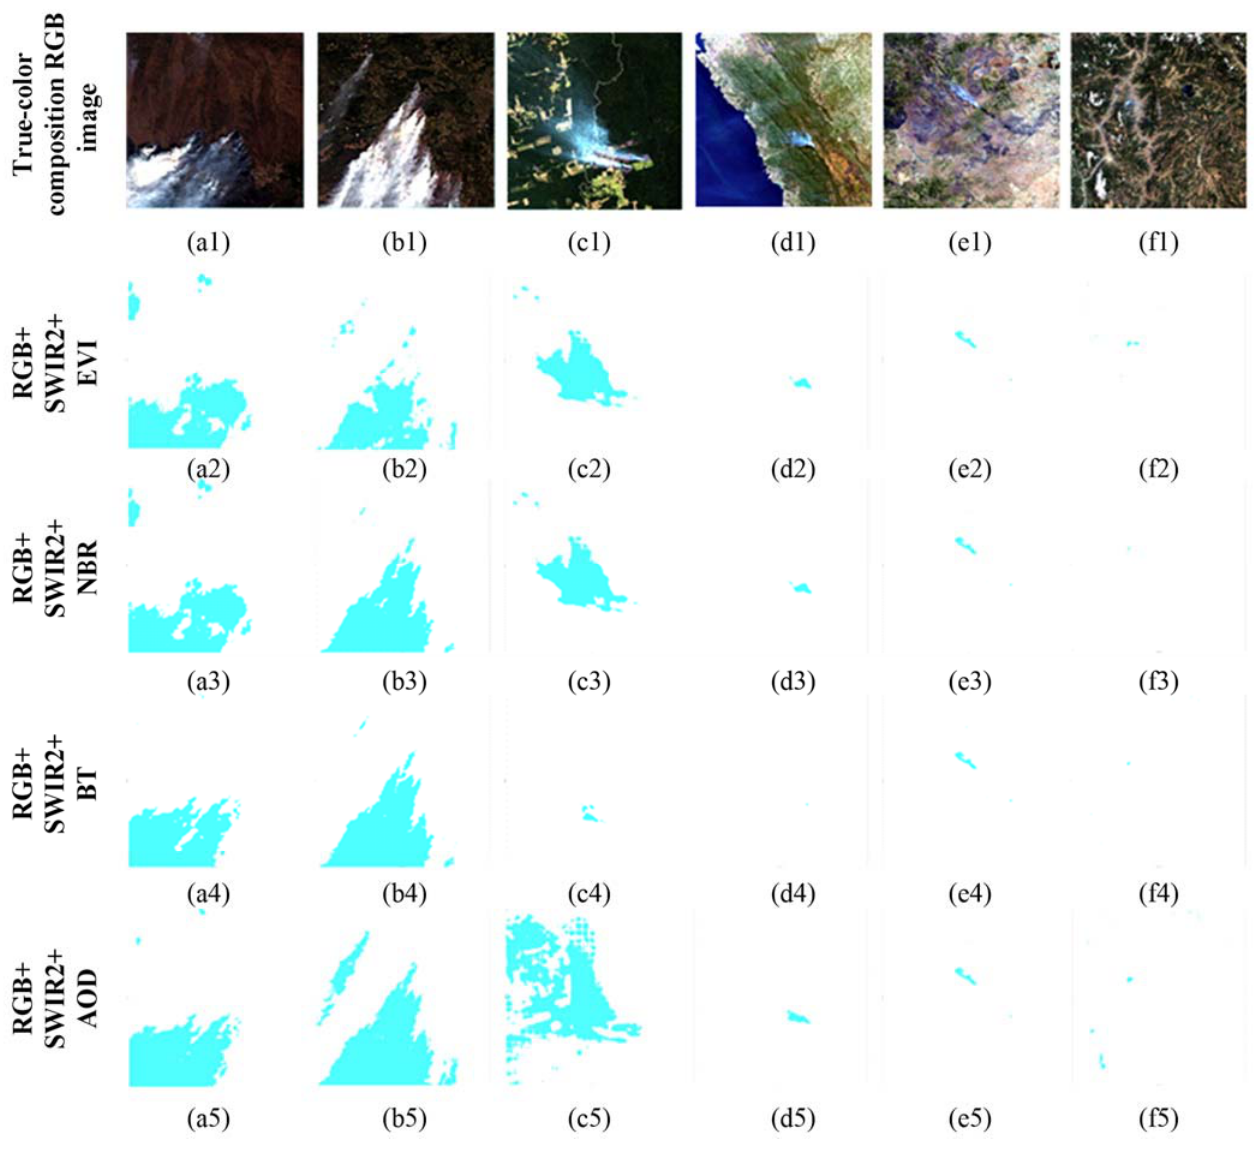
Figure 12. The first line is true ‐ color composition RGB images of smoke plumes. ( a1–a5 ) Siberia area, Russia on 17 Mar 2018; ( b1–b5 ) British Columbia, Canada, on 4 August 2017; ( c1–c5 ) Amazon region, Brazil, on 9 August 2019; ( d1–d5 ) New Zealand area, on 7 February 2019; ( e1–e5 ) Zambia, on 26 June 2017; ( f1–f5 ) Liangshan region, China, on 21 May 2019. All rows except the first are segmentation results of smoke with multiple bands and remote sensing indexes, the smoke pixels are depicted in aqua color.